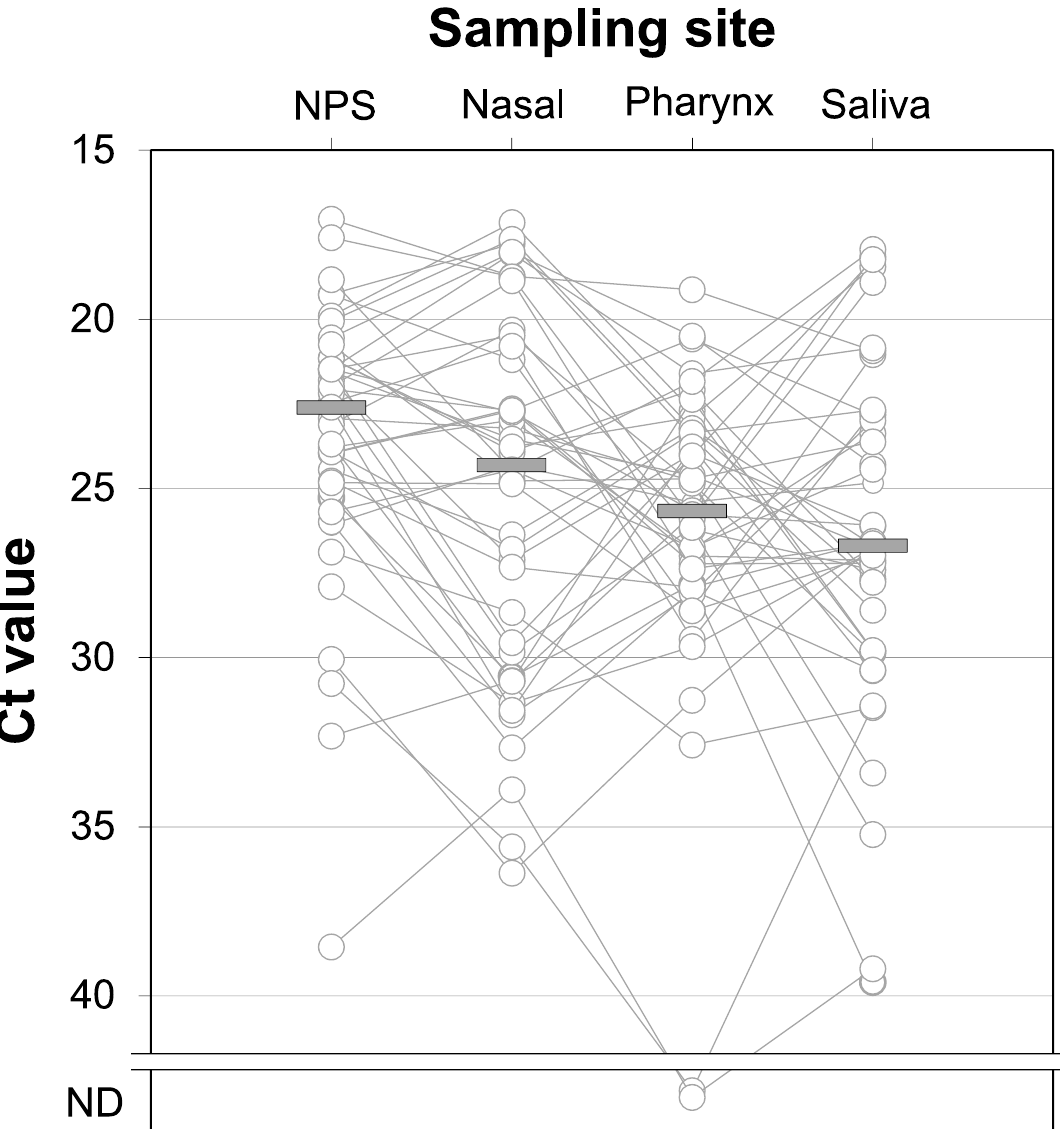
Fig 1. Patient sample Ct values across different sampling sites. ND, not detected; NPS, nasopharyngeal swab; Ct, cycle threshold. https://doi.org/10.1371/journal.pone.0260184.g001 PLOS ONE | https://doi.org/10.1371/journal.pone.0260184 November16,